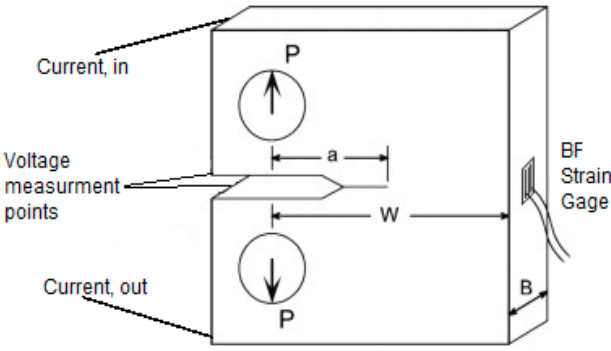
Figure 2. Potential drop method principle with a back face (BF) strain gage.